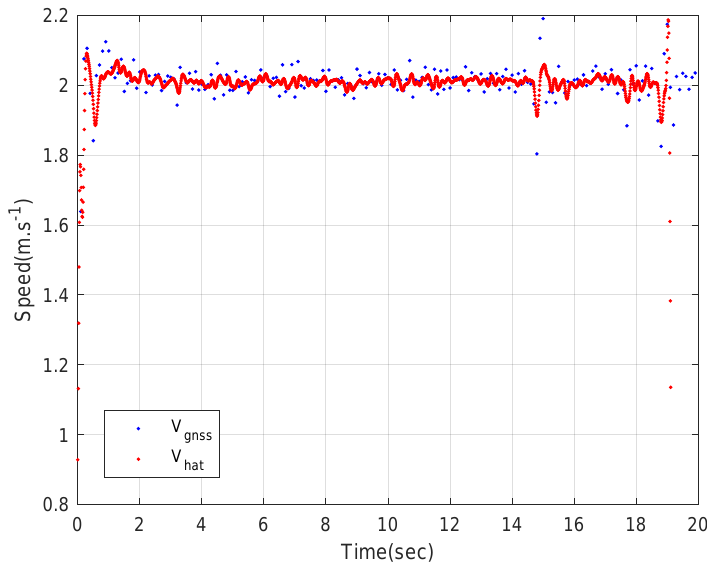
Figure 12. The speed of the rover: a straight driving test.